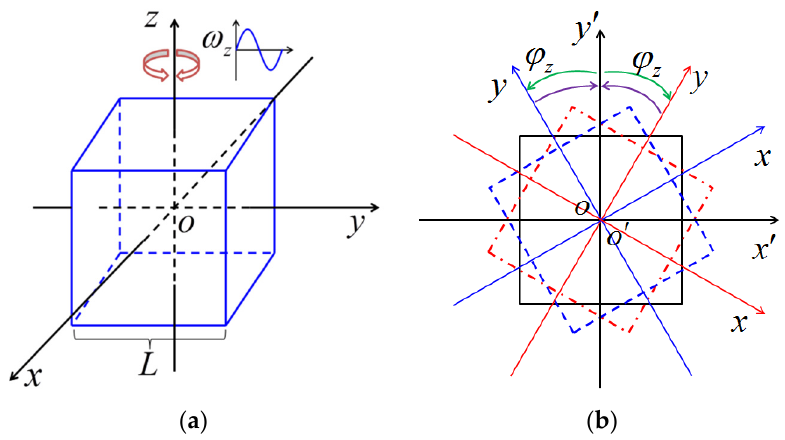
Figure 2. Schematic of the vertical-axis harmonic rotation: ( a ) 3d model, ( b ) top view.